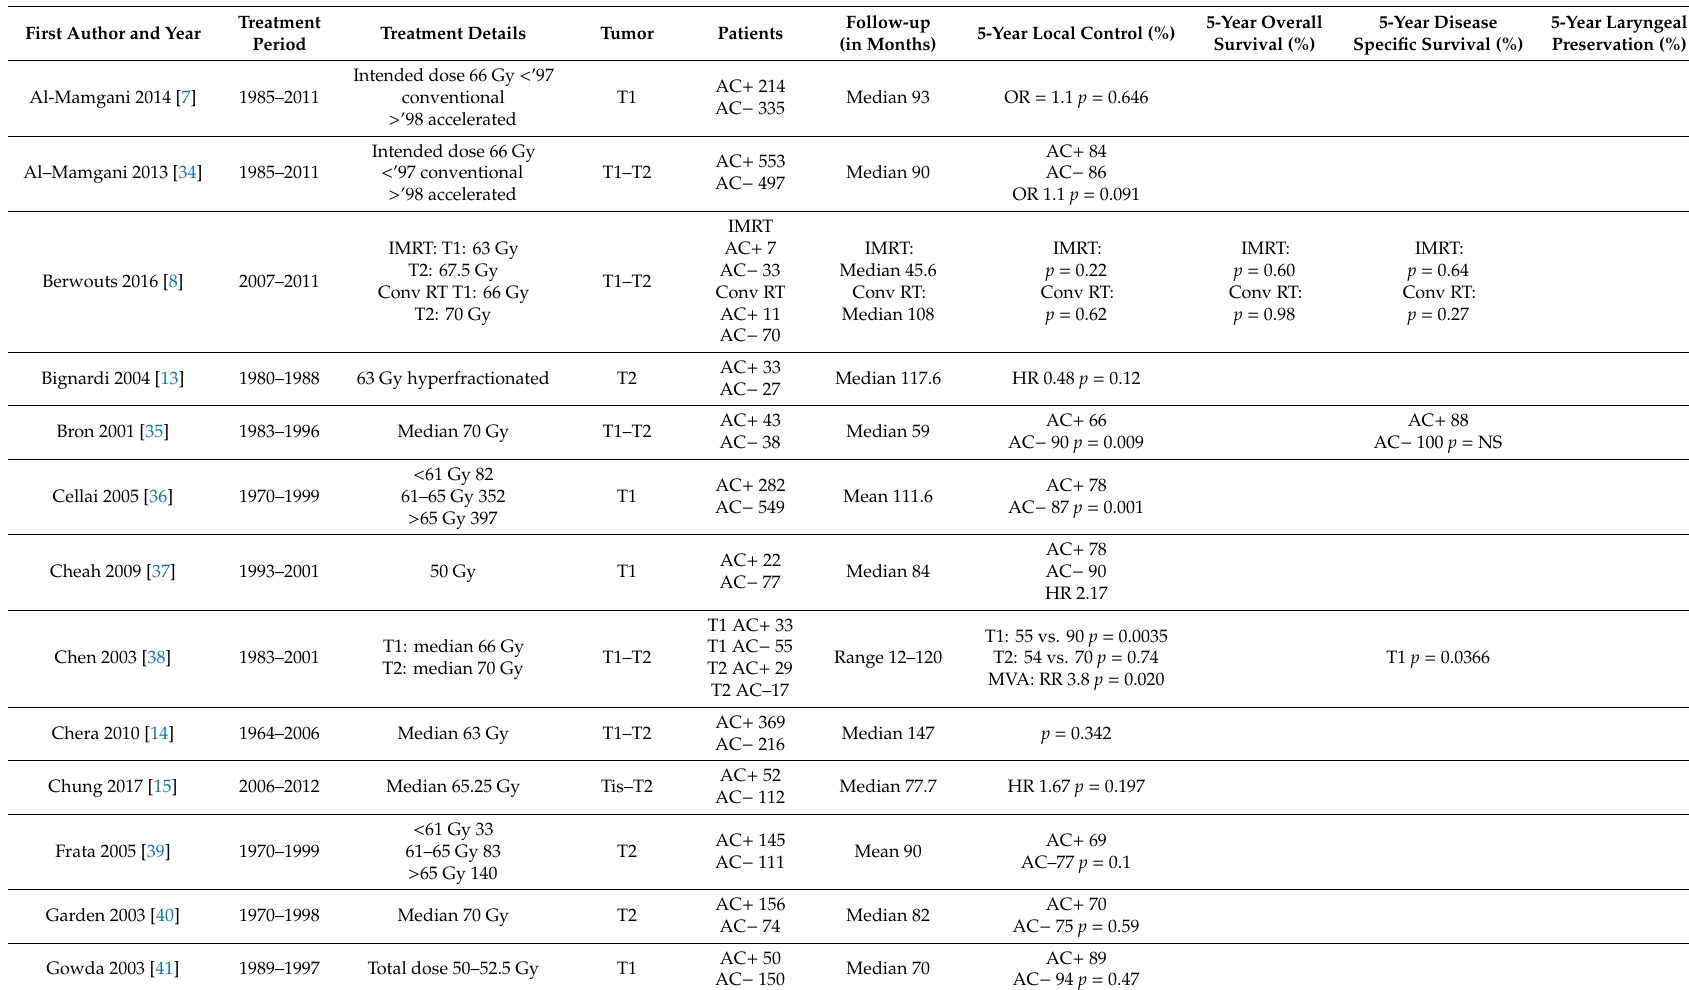
Table 1. Oncological Outcomes of Patients after Treatment with Radiotherapy for Involvement with or without the